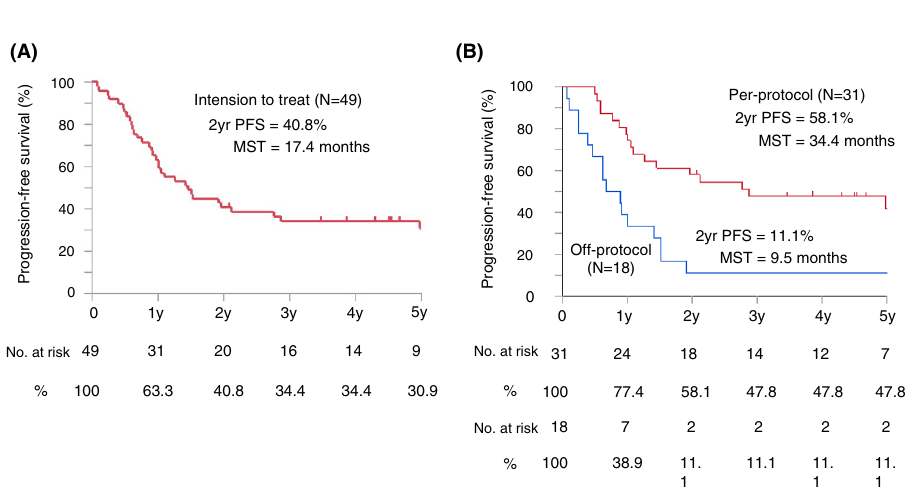
Figure 2. Kaplan–Meier survival curves of progression-free survival. ( A ) Intention-to-treat patients (n = 49). ( B ) Per-protocol patients (neoadjuvant treatment completion and tumor resection, n = 31) and off-protocol patients (neoadjuvant failure or probe laparotomy, n = 18). PFS, progression-free survival; MST, median survival